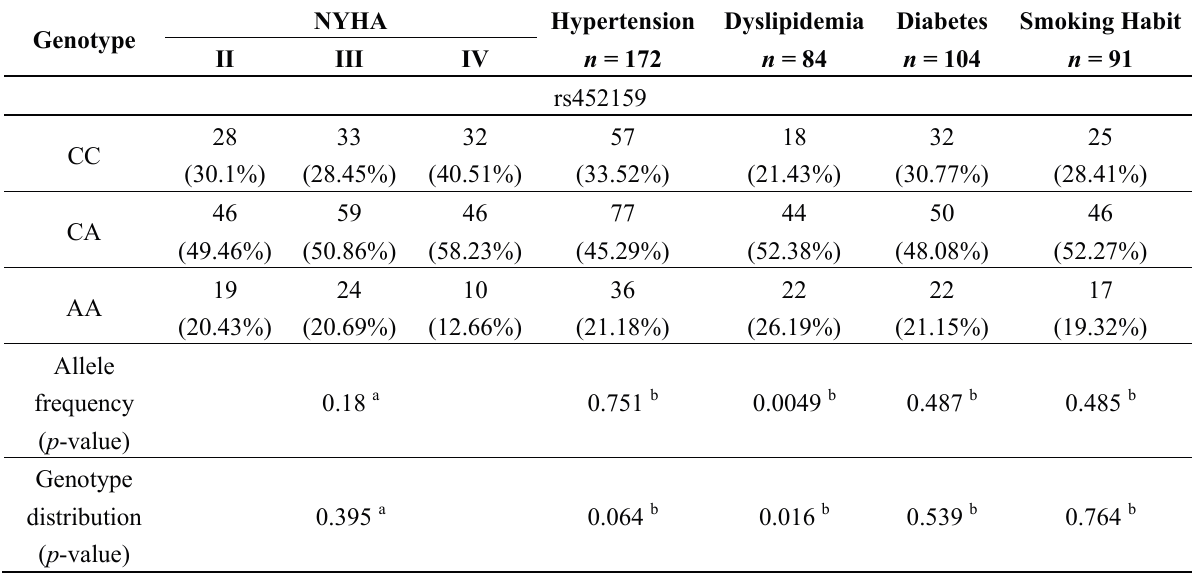
Table 4. R s452159 polymorphisms genotype distribution and allele frequency according to NYHA and subsets of CHF patients.